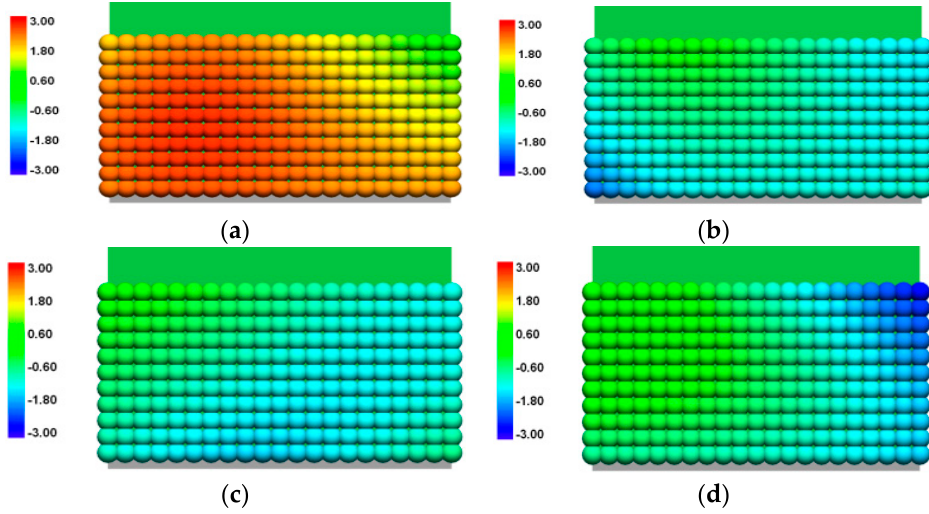
Figure 6. Initial gap fields. ( a ) G 1 (mm). ( b ) G 2 (mm). ( c ) G 3 (mm). ( d ) G 4